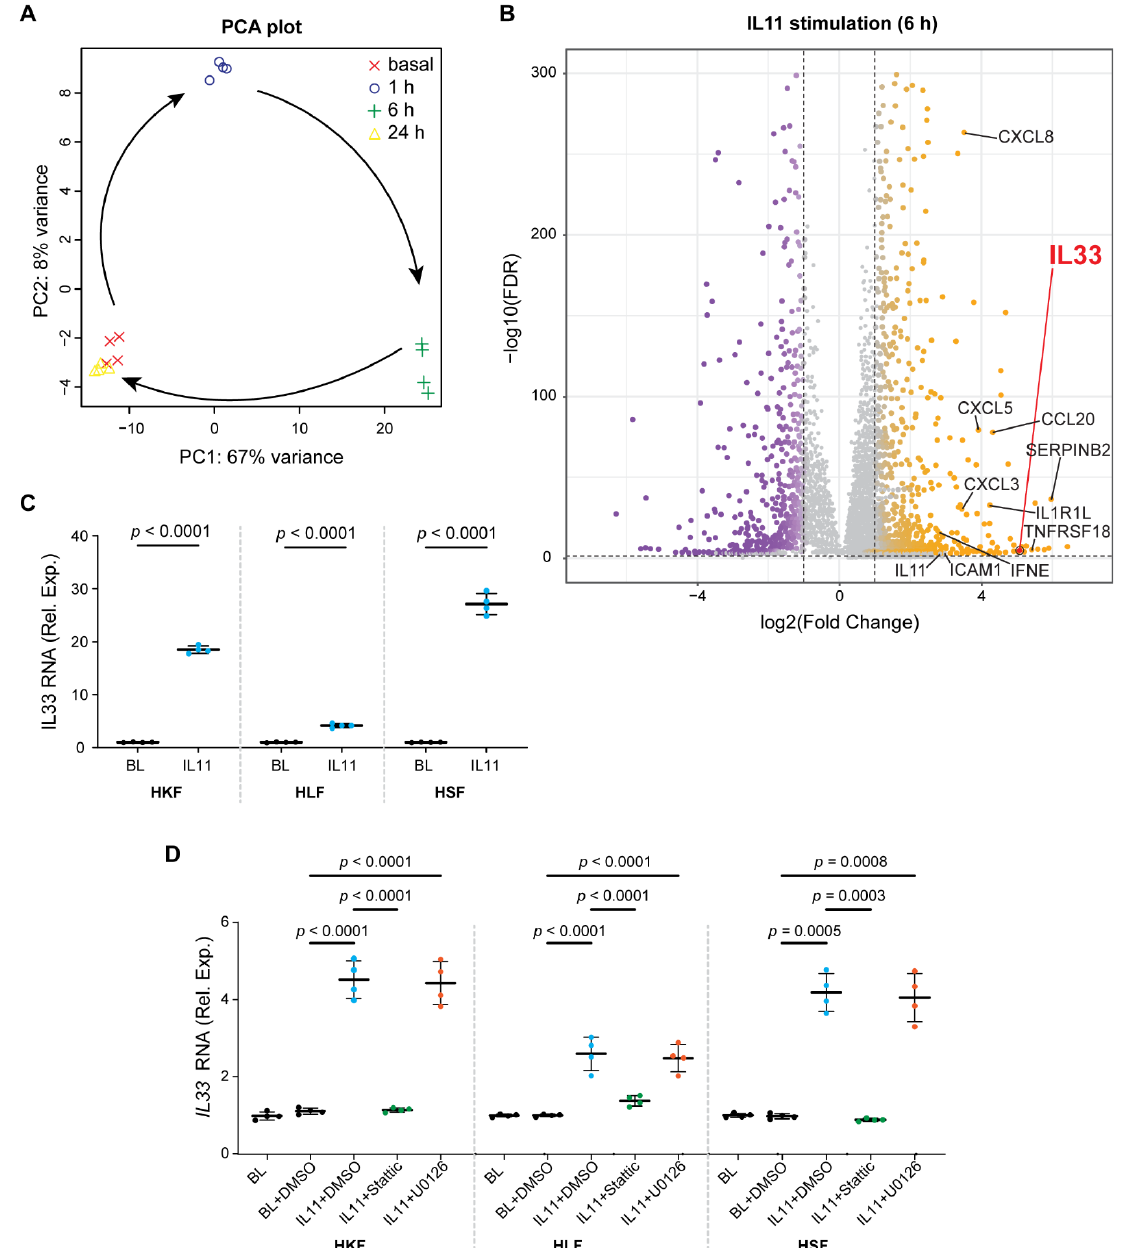
Figure 2. Fibroblasts stimulated with IL11 acquire a pro-inflammatory transcriptome and upregulate IL33 in a STAT3-dependent manner. ( A , B ) Data for RNA sequencing (RNA-seq) experiments on HKF stimulated with IL11 (10 ng/mL) for 0 (basal), 1, 6 and 24 h. ( A ) Principal component analysis (PCA) of RNA-seq across the time series. PC1 and PC2 account for 67% and 8% of the variance in the gene expression, respectively. ( B ) Volcano plots displaying fold change (FC) of genes between baseline and IL11-stimulated cells at 6 h time point. Dashed lines are drawn to define the restriction of log2 FC of 1 (vertical) and − log10 FDR of 0.05 (horizontal). Upregulated, downregulated and non-differentially expressed genes are labeled in orange, purple and gray, respectively. IL33 is annotated separately for clarity. ( C ) Relative mRNA expression (Rel. Exp.) of IL33 in HKF, HLF and HSF following 6 h stimulation of IL11 compared with basal (BL) by qPCR; two-tailed Student’s t -test. ( D ) Relative IL33 mRNA expression in BL and IL11-stimulated HKF, HLF and HSF in the presence of either DMSO, Stattic (STAT3 inhibitor, 2.5 µ M) or U0126 (MEK inhibitor, 10 µ M); one-way ANOVA with Tukey’s correction. ( C , D ) Data are shown as mean ± SD (n = 4 biological